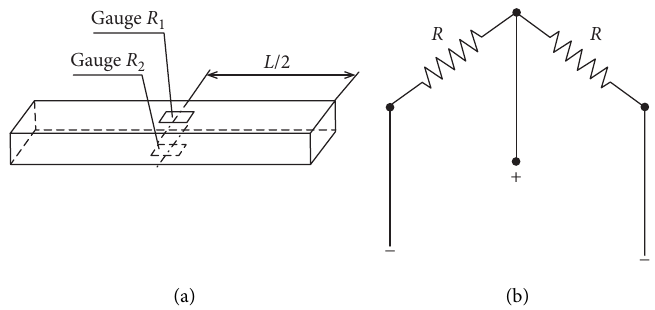
Figure 2: (a) Position of the gauges; (b) Wheatstone half-bridge cabling diagram of the gauges.